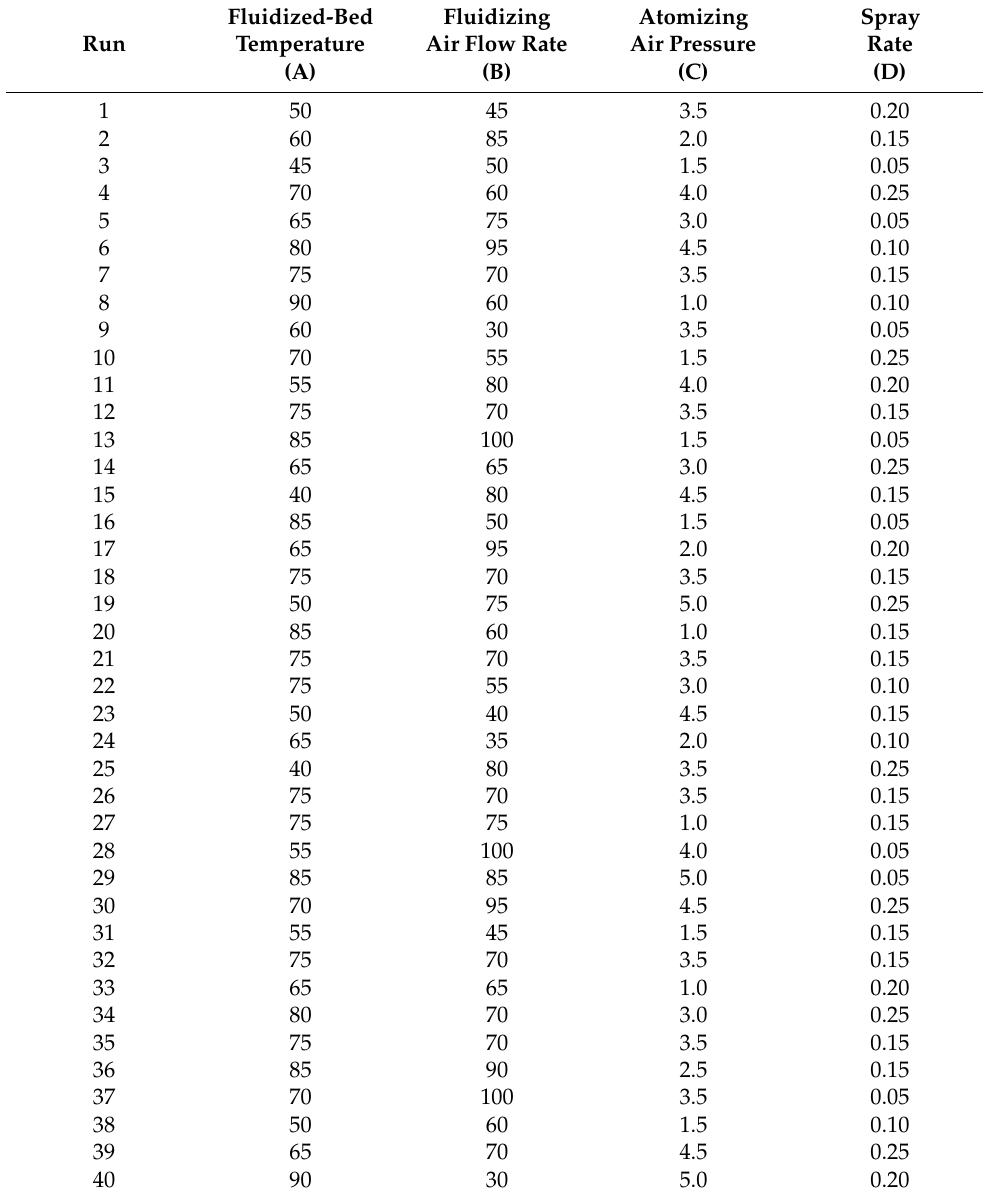
Table 3. Experimental matrix (design of experiments) based on the central composite rotatable design